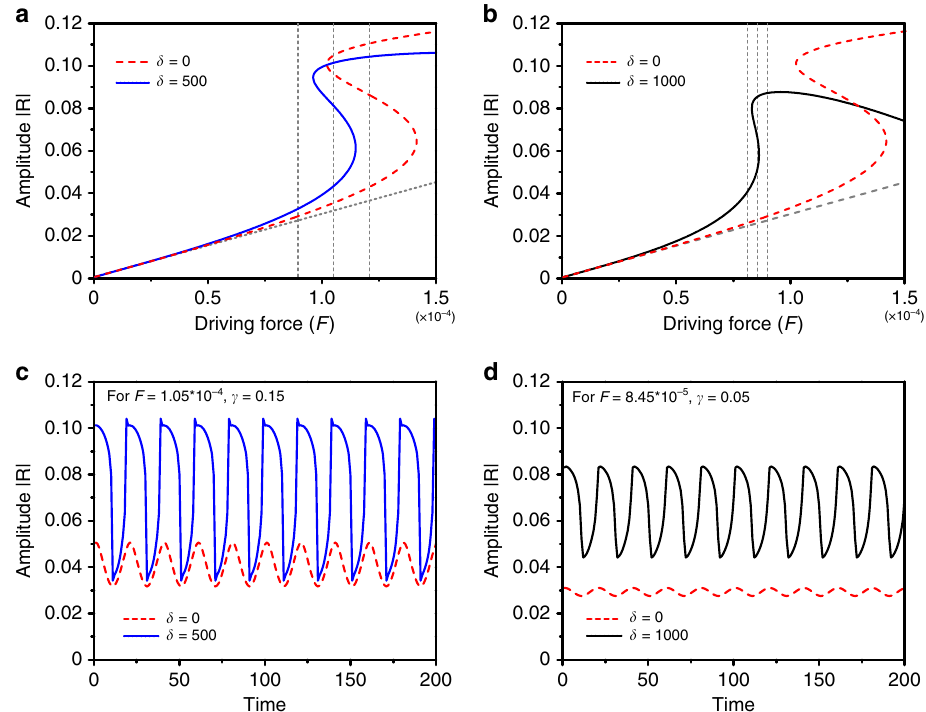
Fig. 4 Numerical investigation of the steady-sate responses versus driving amplitude. In a , b , the red dashed lines represents the steady state response ∣ R ∣ versus F for γ = 0.15 and δ = 0 (no additive amplitude modulation). This is compared to a δ = 500 (blue line), and b δ = 1000 (black line). Vertical dashed lines in a , b lie at F = F 0 (1 ± γ ) and F = F 0 , corresponding to the extreme and middle of the signal modulation. Other parameters are σ = 0.0016, η = 0.001, α = 0.4. The grey lines mark the linear regime (small driving limit F → 0). c , d : time traces of the response ∣ R ∣ corresponding to the maximum signal ampli fi cation in a and b , with respectively in c F 0 = 1.05 × 10 − 4 and δ = 0 (red dashed line) or δ = 500 (blue line) and in d F 0 = 8.45 × 10 − 5 and δ = 0 (red dashed line) or δ = 1000 (black